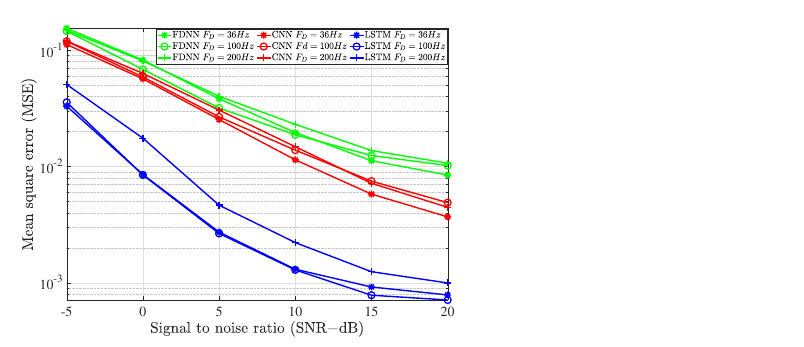
Figure 15. The impact of the pilot density on the deep learning-based channel estimations.